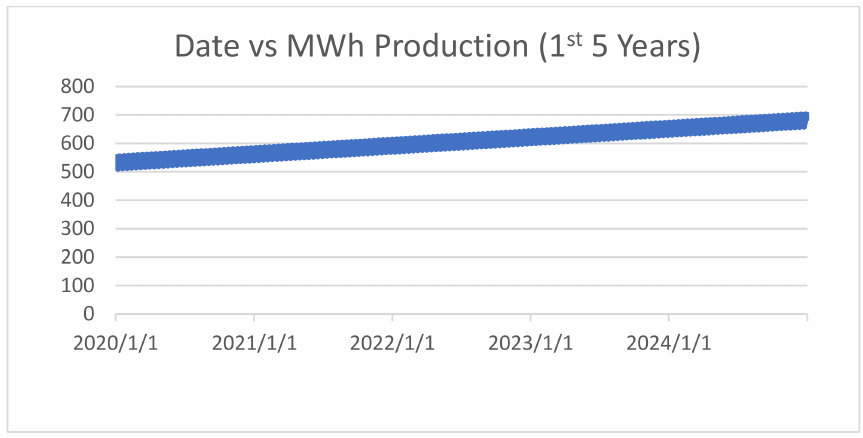
Figure 8. First 5 years’ prediction results of MWh from 1 January 2020 to 1 January 2024.